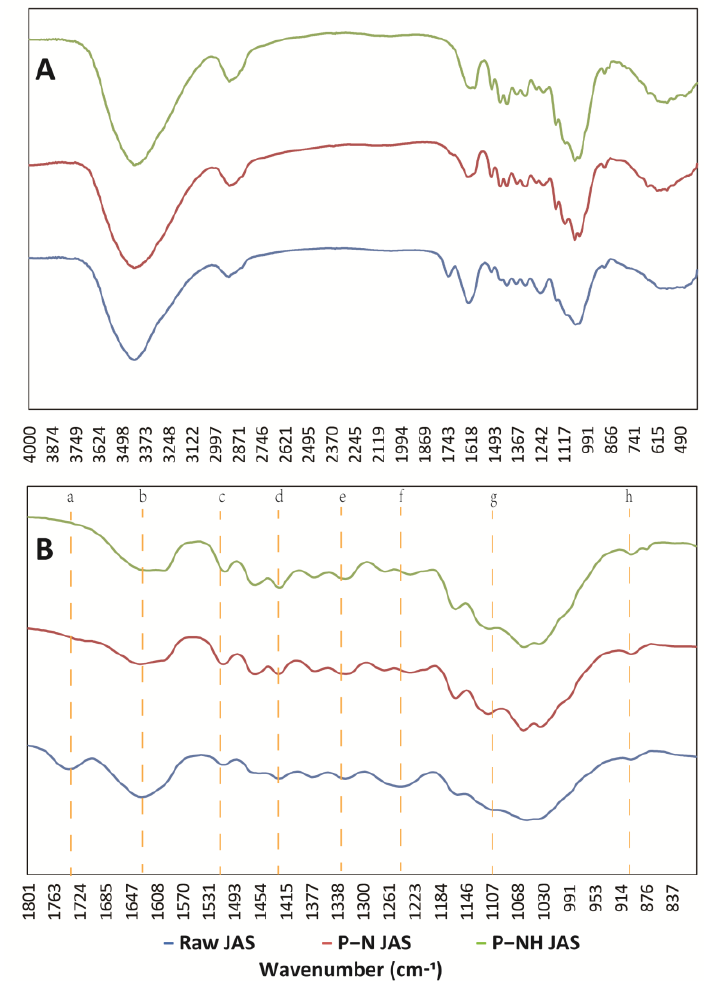
Figure 6. FTIR spectroscopy fingerprints of raw and pretreated JAS. ( A ) The wavenumber range is 500 cm −1 – 4000 cm −1 . ( B ) The wavenumber range is 800 cm −1 – 1800 cm −1 . P-N JAS: NaOH-pretreated JAS, P-NH JAS: CO-pretreated JAS. (a) 1735 cm −1 , (b) 1630 cm −1 , (c) 1515 cm −1 , (d) 1425 cm −1 , (e) 1329 cm −1 , (f) 1240 cm −1 , (g) 1104 cm −1 , (h) 897 cm −1 . The peak at 1630 cm −1 (indicates -C-O-) reflected the content of lignin (Figure 6B). After the first pretreatment, a significant decrease in lignin was observed, and then an increase after the second pretreatment was shown (but still less than that of raw materi- als), which is consistent with the results stated in Table 1. However, other peaks of lignin at 1515 cm −1 (aromatic skeletal from lignin) and 1329 cm −1 (syringyl and guaiacyl con- densed lignin) had no significant change, which explained that lignin still existed in the pretreated JAS in a considerable amount. The absorption peak of hemicellulose is at 1735 cm −1 , indicating a change in the C=O bond in hemicellulose. Both the raw JAS and the NaOH-pretreated JAS obtained after the first pretreatment showed this peak (the peak appeared both in the raw JAS and NaOH-pretreated JAS obtained after the first pretreat- ment), which indicated the existence of hemicellulose. However, the peak (1735 cm −1 ) after the 2nd pretreatment was not obvious, which indicated that hemicellulose was removed by acid pretreatment. The peaks at 1425 cm −1 , which represent the CH 2 in crystalline cel- lulose, diminished after pretreatment, and the peak at 897 cm −1 corresponds to the bending vibration of cellulose. After the pretreatments, these two peaks both had enhanced ratios among all the peaks, indicating an increase in the cellulose content. The variation in the concentrations of cellulose, hemicellulose, and lignin is consistent with the FTIR analysis results (Table 1).